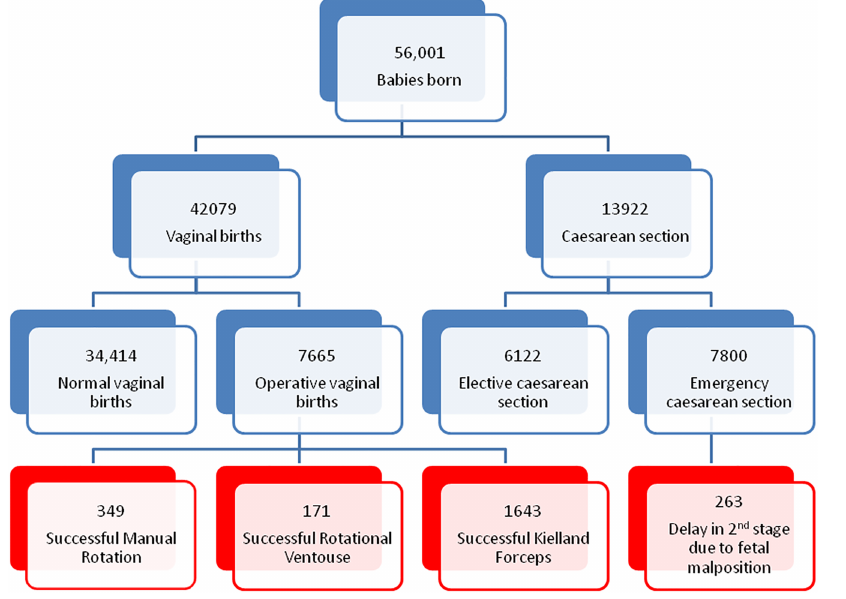
Fig 1. A Flowchart demonstrating how our final data set was captured.